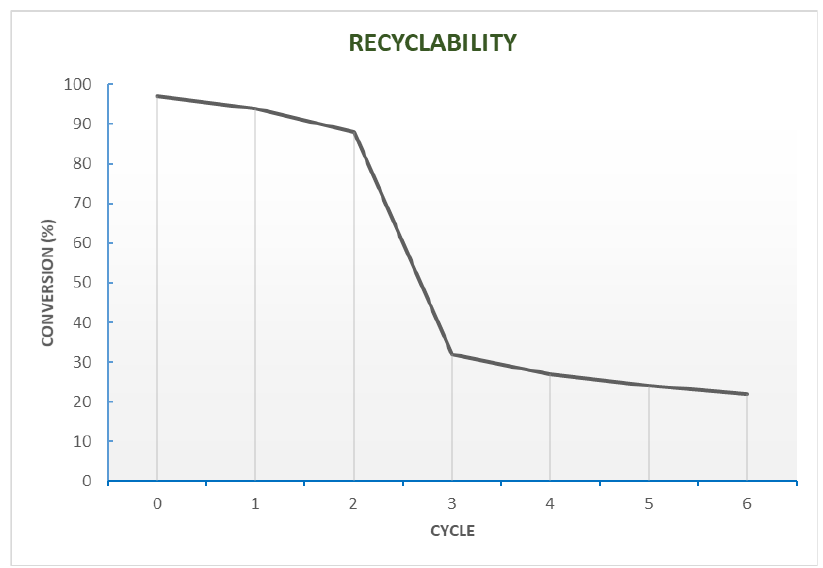
Figure 4. Pd-wool complex cycle trend. Adapted from Reference [34]. Copyright 2012, Royal Society of Chemistry.